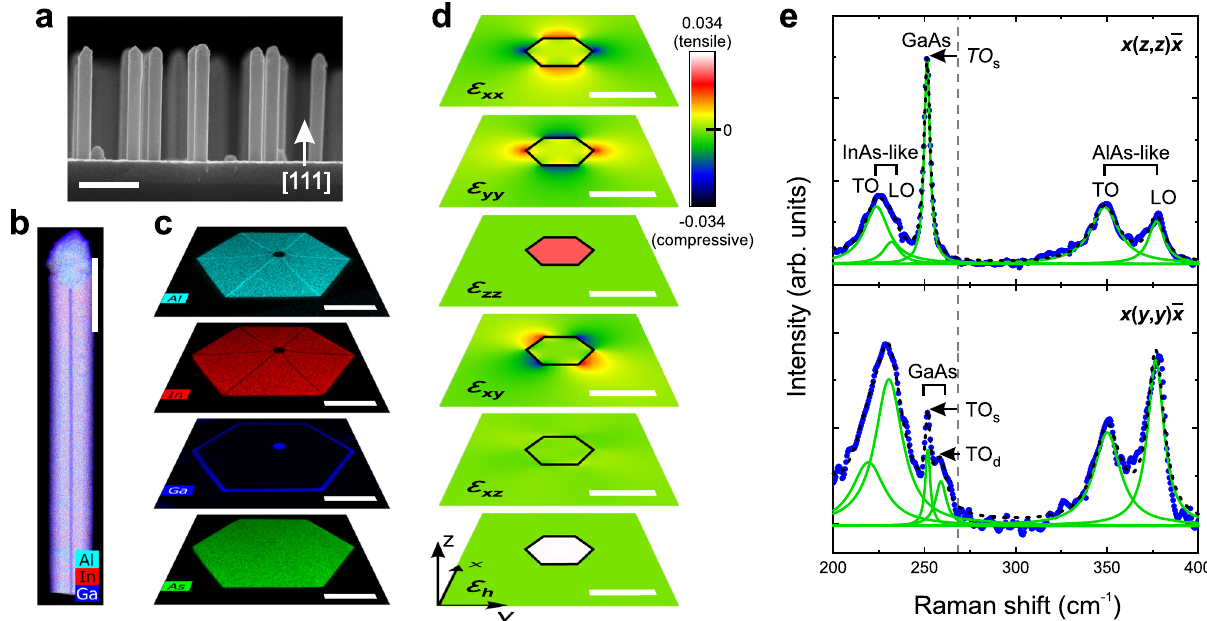
Fig. 1 Morphology, chemical composition and strain of the investigated GaAs/In 0.37 Al 0.63 As core/shell (uncapped) and GaAs/In 0.43 Al 0.57 As/ In 0.44 Ga 0.56 As core/shell/capping-shell (capped) nanowires. a Side-view scanning electron microscopy (SEM) image of as-grown capped nanowires on a Si(111) substrate. b Energy-dispersive X-ray spectroscopy (EDXS)-based compositional map from the side of one capped nanowire. The signal from Al, In and Ga is illustrated in cyan, red and blue, respectively. c Individual EDXS-based compositional maps for each constituent element perpendicular to the axis of a capped nanowire. Here, a TEM lamella from the middle of a nanowire was analysed. The signal from As is illustrated in green. d Simulated strain components close to the core of an uncapped nanowire using continuum elasticity theory. The core is outlined with a black line. e Raman scattering spectra at room temperature from a single uncapped nanowire in two different polarisation con fi gurations: x ( z , z ) x ̅ at the top, and x ( y , y ) x ̅ at the bottom. The measured data were plotted with blue points and the fi tted curves with lines: green for the individual peaks and dashed black for the cumulative curve. The scale bars correspond to 1 µ m in ( a ), 400 nm in ( b ), 60 nm in ( c ) and 20 nm in ( d ). Table 1 Simulated and measured strain components in the core of two types of GaAs/In x Al 1- x As core/shell nanowires.